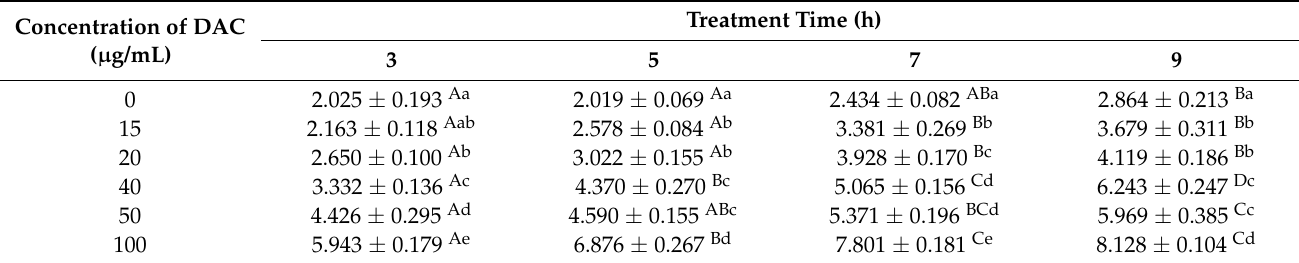
Table 12. The effect of DAC on T-AOC in GMEC (U/mL).